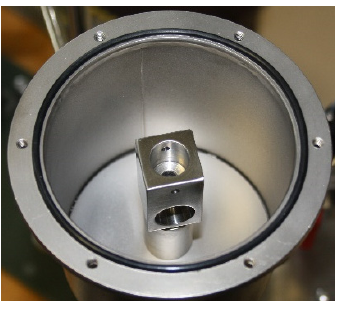
Figure 8. Position of the acoustic connector mounting on the PAT housing.